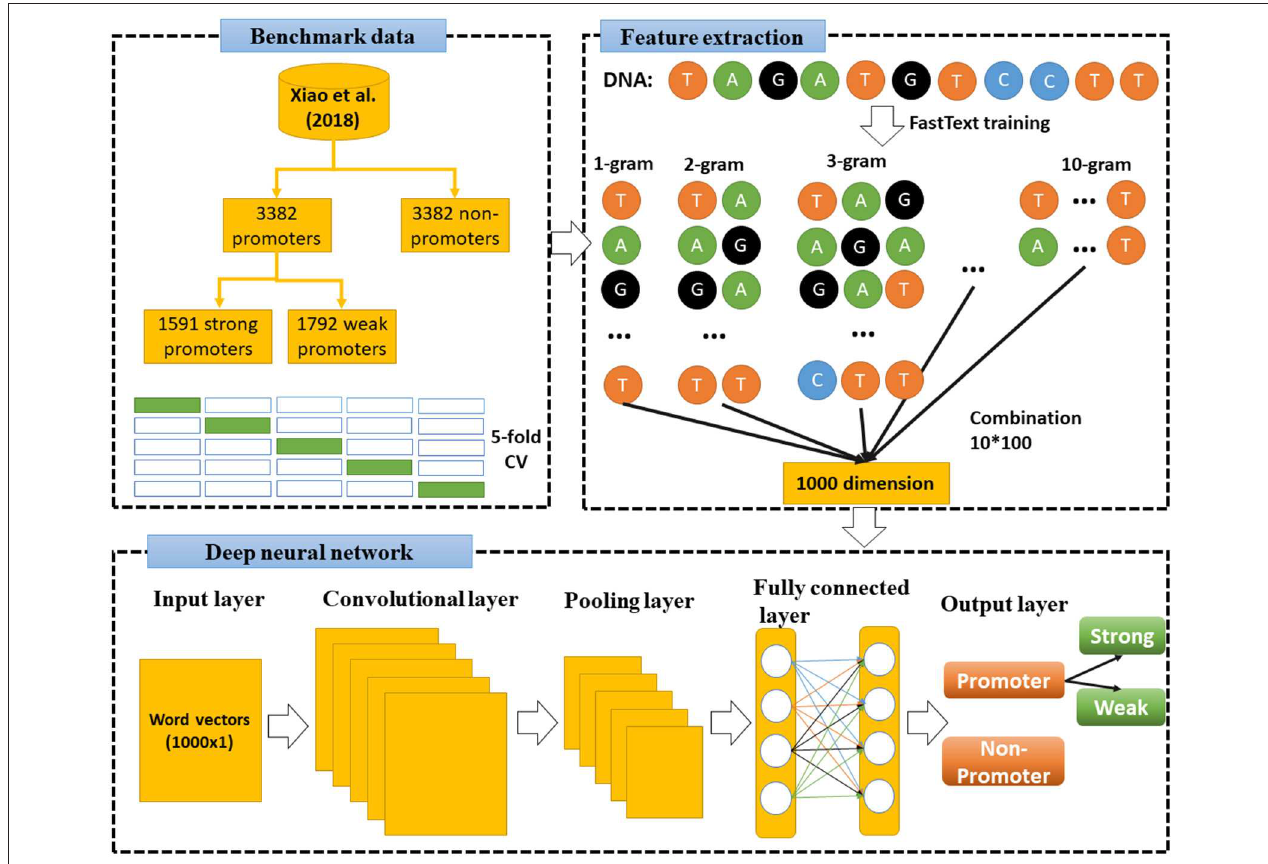
FIGURE 2 | Flowchart of this study. First, we used FastText to train model and extract features from benchmark dataset (Xiao et al., 2018), then combined 10-gram levels to a combination sets of vectors (1,000 dimensions). Deep neural network was then constructed to learn these vectors and classify the DNA sequences.